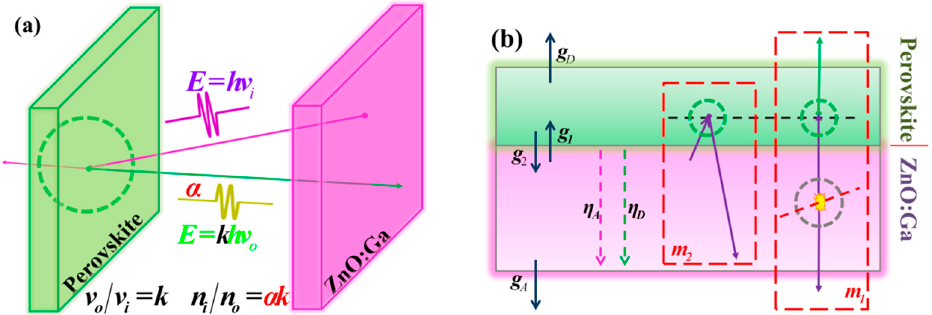
Figure 7. Schematic diagram for theoretical analysis: ( a ) conversion process of photons in the perovskite film; ( b ) quantitative optical path analysis.